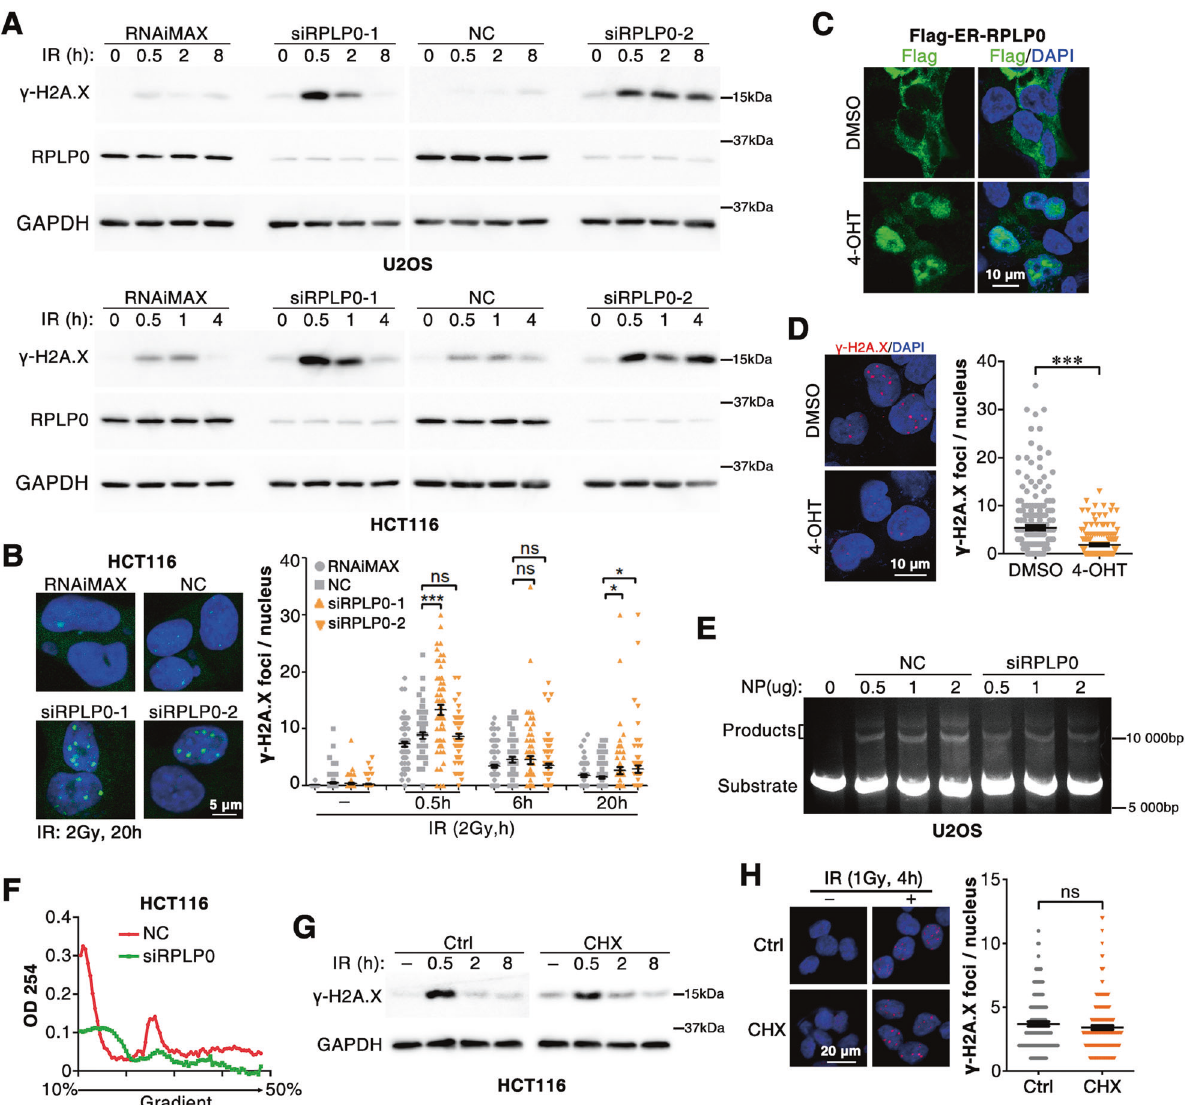
analysis. B Knockdown of RPLP0 increases γ -H2A.X foci in tumor cells after IR. Thirty-six hours after transfection, HCT116 cells were irradiated (2 Gy) and cultured for indicated time. Cells were fi xed and subjected to immuno fl uorescence analysis. n = 120, 85, 59, 96, 73, 58, 62, 75, 96, 62, 68, 93, 71, 81, 64, and 68 (from left to right column). Scale bars, 10 μ m. C 4-OHT induces the nuclear import of ER-RPLP0. Cells were treated with 300 nM 4-OHT for 4 h before IF assay. Scale bars, 10 μ m. D Nuclear RPLP0 enhances DNA repair. Thirty minutes before irradiation (2 Gy), 300 nM 4-OHT was added to medium. Cells were cultured for 20 h after irradiation. n = 203 (DMSO), n = 170 (4-OHT). Scale bars, 10 μ m. E Depletion of RPLP0 suppresses the ligation of linearized DNA in vitro. pCSCMV-tdTomato plasmid was linearized with BamHI and incubated with nuclear protein of U2OS cells. The ligation product was separated using 0.8% agarose gels. F RPLP0 silencing suppresses translation. Forty-eight hours after siRNA transfection, cells were subjected to polysome pro fi le assay. The impact of translation inhibitor cycloheximide (CHX) on DNA repair capacity was examined using western blotting ( G ) or IF assay ( H ). HCT116 cells, treated with 100 μ g/ml CHX for 12 h, were irradiated and cultured for indicated time before western blotting ( G ) or IF assay ( H ). n = 148 (Ctrl), n = 183 (CHX). ***, P < 0.001; ns no signi fi